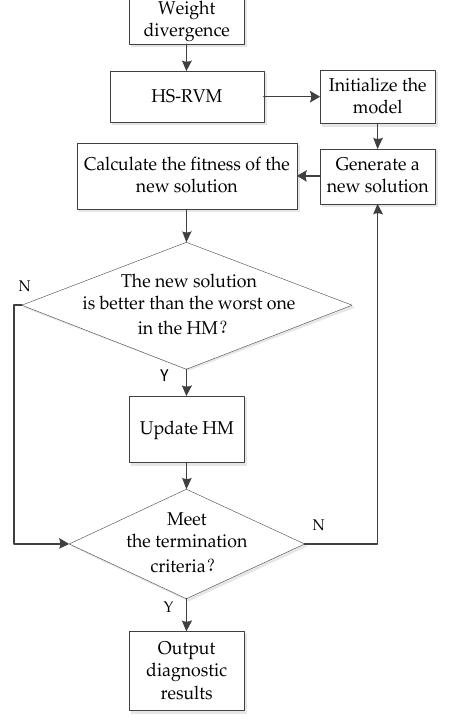
Figure 2. Fault classification algorithm flow chart.